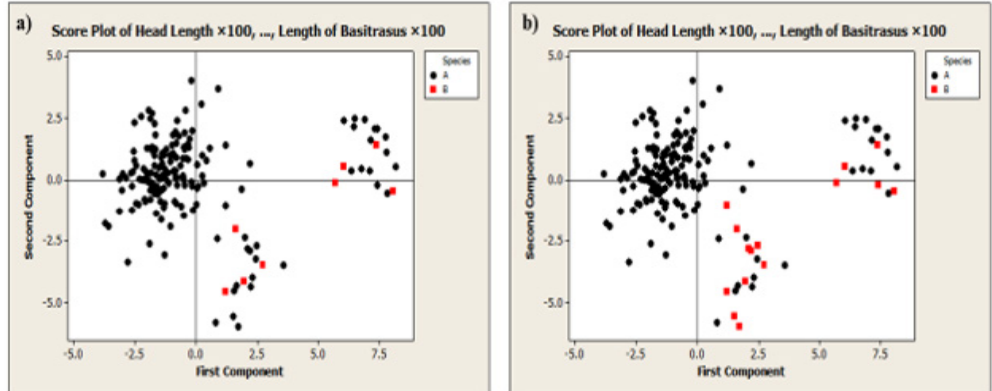
Figure 2: Score plots ( a) Assumption 1*: b) Assumption 2*) from the PCA analysis for all measured morphological characters of male Phlebotomus ( Euphlebotomus ) argentipes in the studied sand fly population.